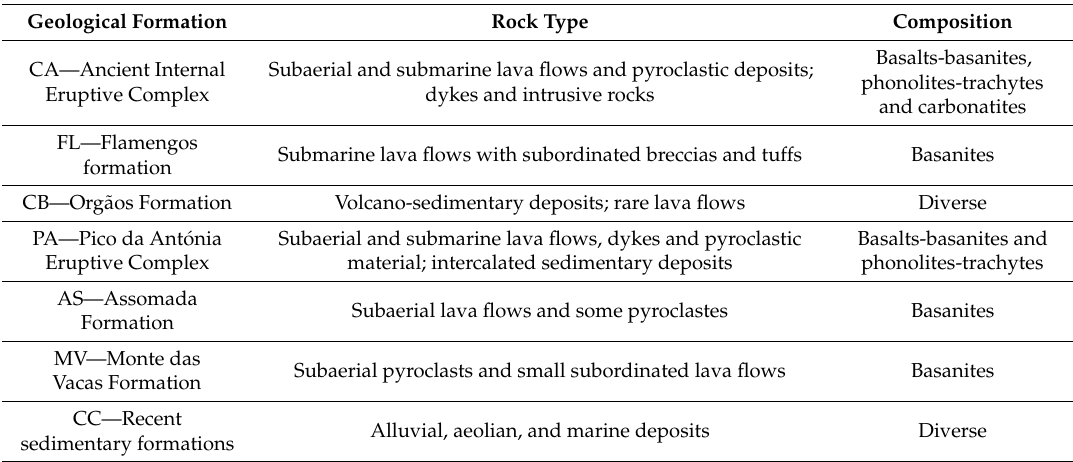
Table 1. Brief description of each geological formation of the soils of Santiago Island.